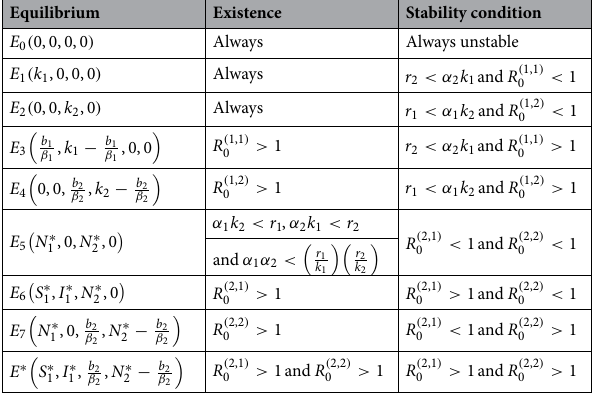
Table 2. Equilibria and their stability of model (2), where r 1 = b 1 − d 1 , r 2 = b 2 − d 2 , α 1 = r 1 p / k 1 − ε a , α 2 = r 2 q / k 2 + a , S ∗ 1 = 1